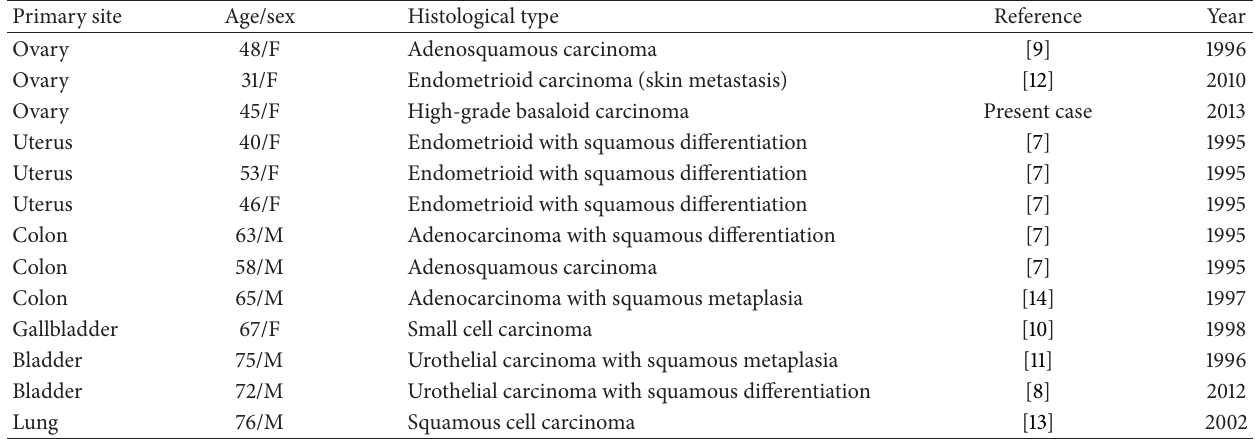
Table 1: Reported cases of visceral carcinoma with shadow cell